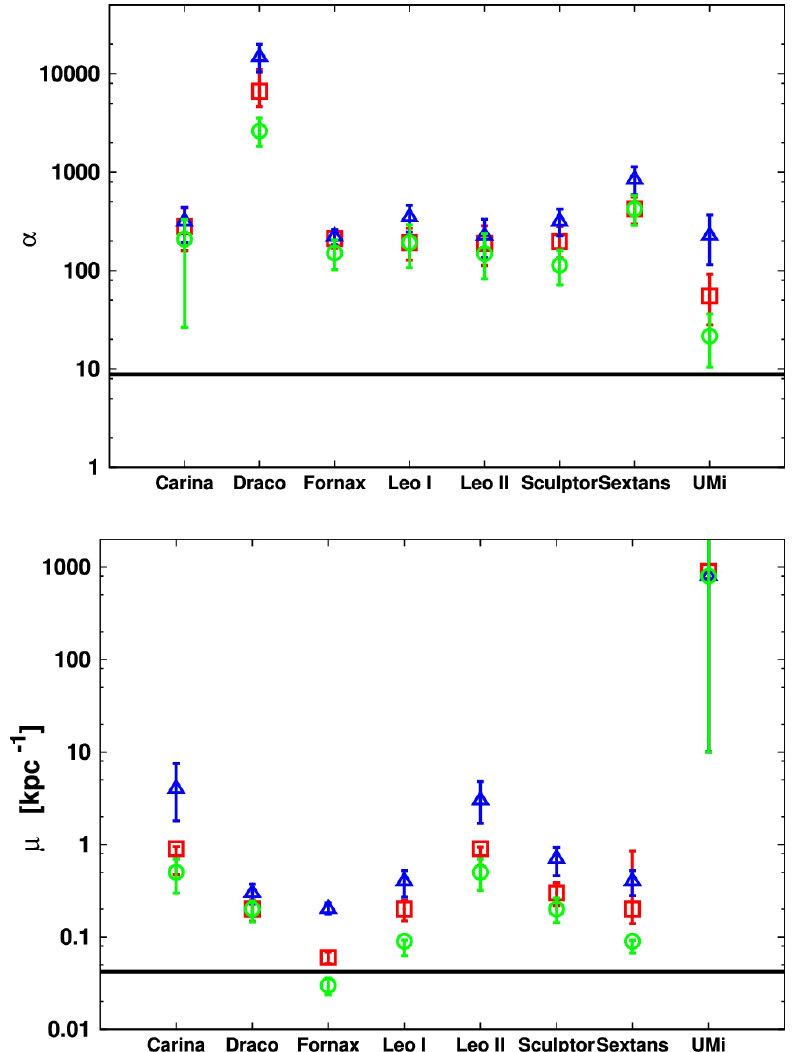
Figure 26. The top and bottom panels show the best-fit α and µ parameters of the MOG gravitational potential in Equation (24) with their uncertainties as obtained from the analysis of dSphs. The solid lines show the values obtained by fitting the rotation curves of more massive galaxies [603]. For each galaxy, three assumptions on the mass-to-light ratio are used, i.e., M / L V = [ 0.5,2,5 ] , corresponding to blue triangles, red squares, and green circles respectively. The figure is reproduced from